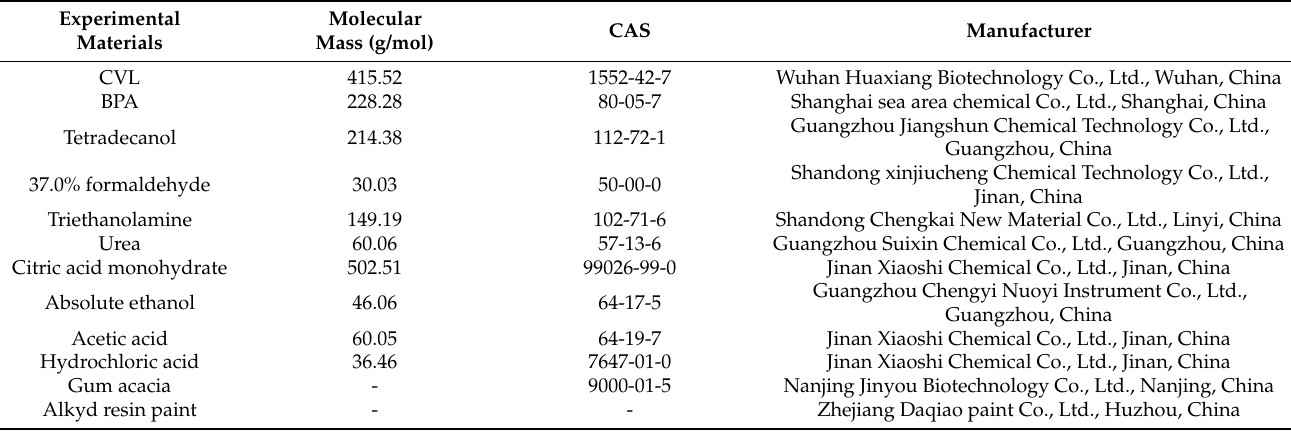
Table 1. List of experimental